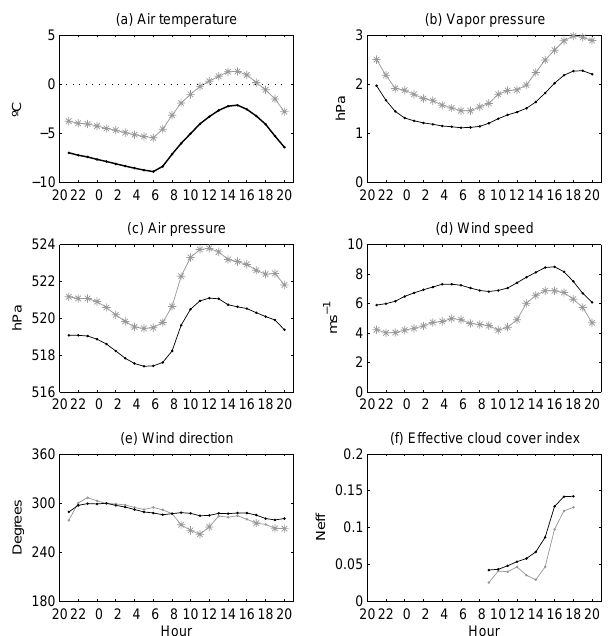
Fig. 8. Mean diurnal cycle in meteorological conditions for days with melt (grey line) and days without melt (black lines). Wind di- rection is calculated from the mean u , v orthogonal components. Hours during which melt days are statistically different than non- melt days ( p < 0 . 05) are indicated by an asterisk. The same permu- tation test used for energy fluxes was